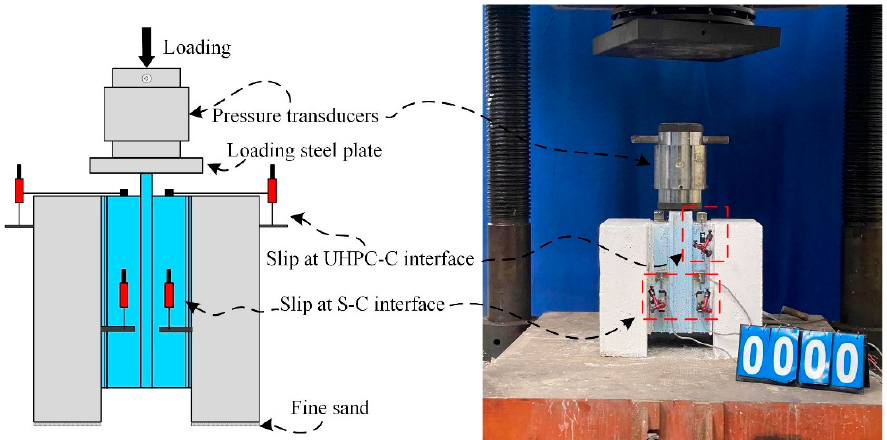
Figure 9. Test setup and layout of displacement transducer.